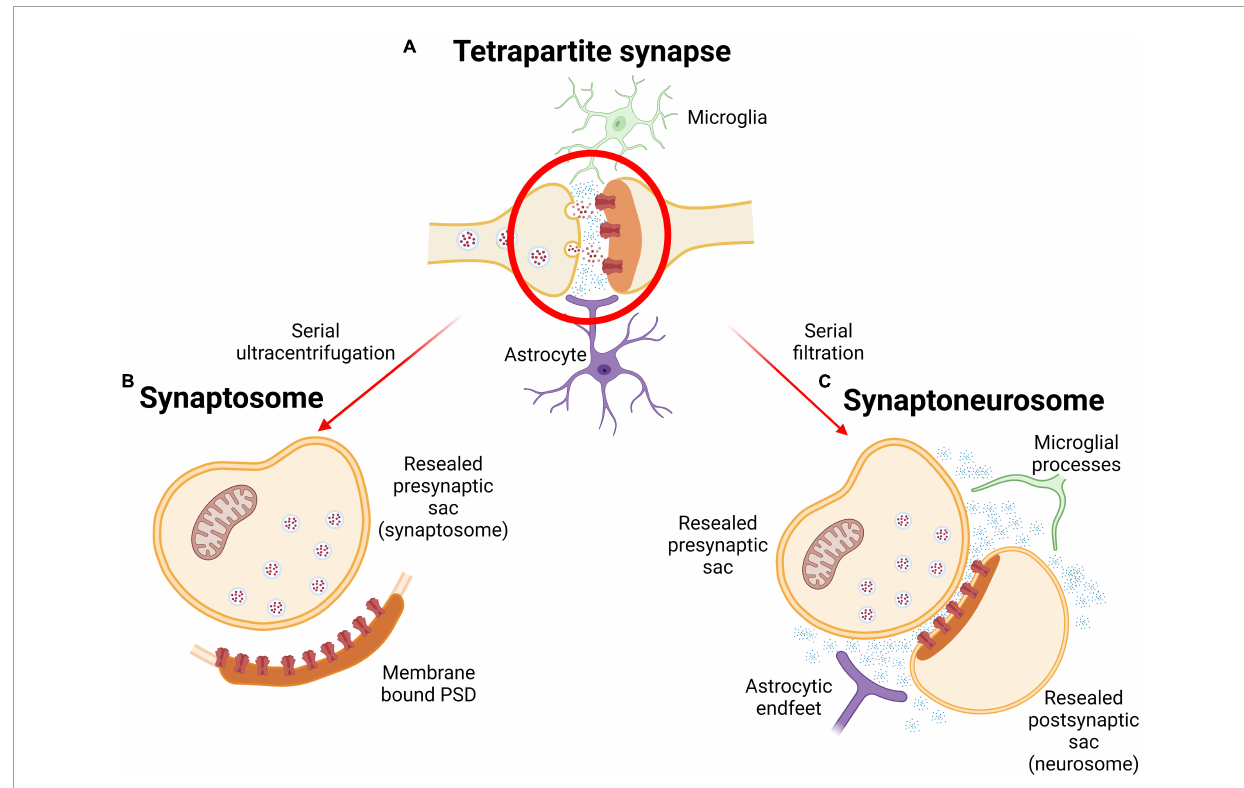
FIGURE2 Subcellular isolation of synapses. (A) Depiction of the tetrapartite synapse including glial influences and ECM (blue dots) in the extracellular synaptic space. (B) Synaptosome produced through gradient ultracentrifugation. (C) Synaptoneurosome (SNS) contains microglial processes and astrocytic endfeet as well as EMC molecules, and represents a “crude” synaptic fraction. Created with